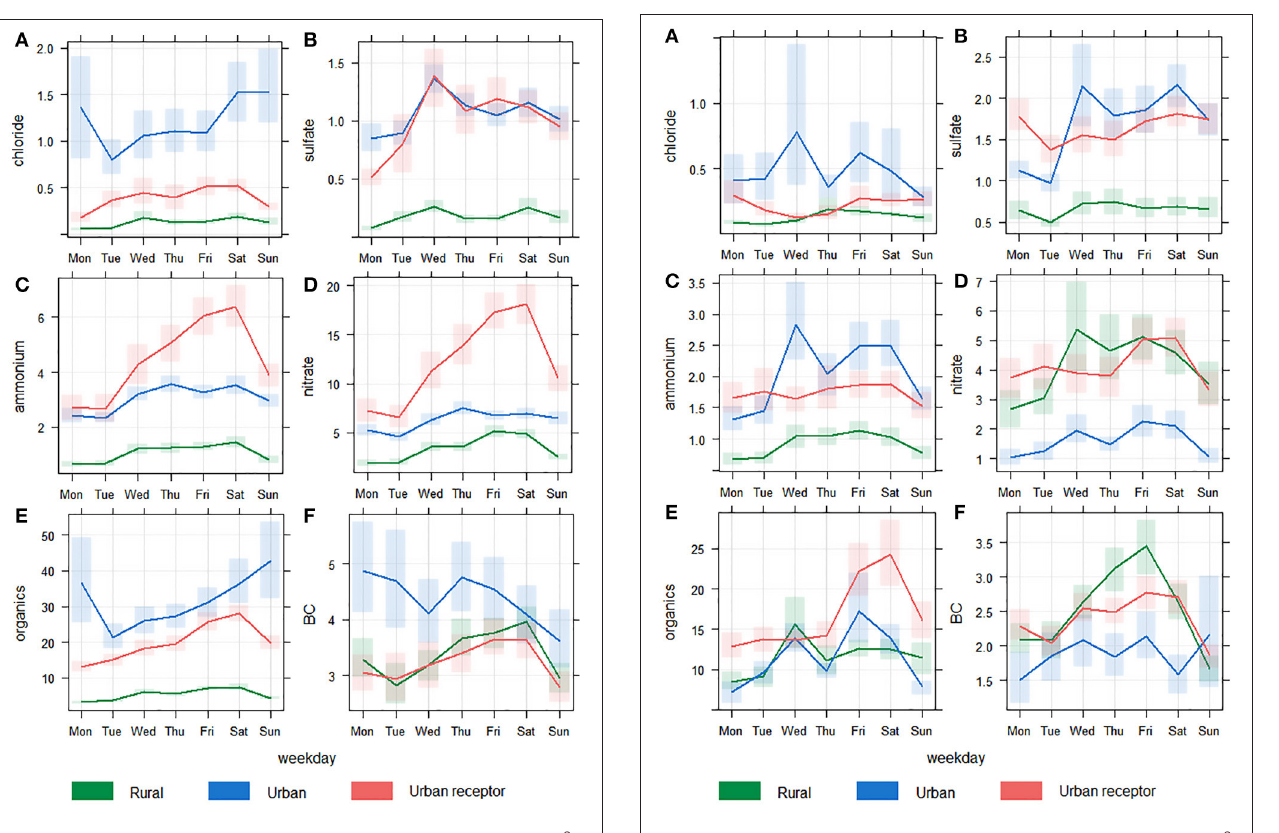
FIGURE 9 | Weekly temporal profile of 1-h average concentrations ( µ g m − 3 ) during the winter season. (A) chloride, (B) sulfate, (C) ammonium, (D) nitrate, (E) organics, (F) black carbon. Mean (solid line) and 95% confidence intervals in the mean (transparent bar).